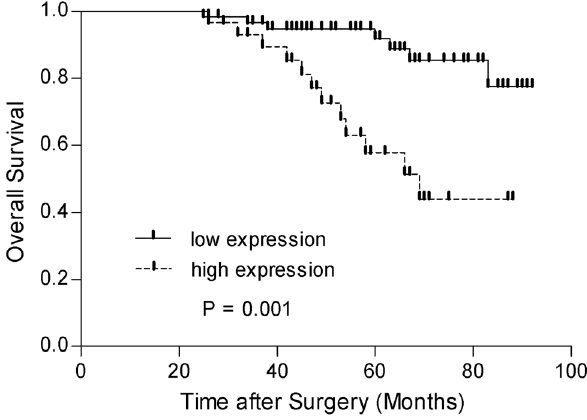
Figure 3. Kaplan-Meier curves of RCC patient OS according to PROX1 expression. OS is decreased in patients with high PROX1 expression compared with those with low levels of PROX1 expression ( P =0.001, Log-Rank test).